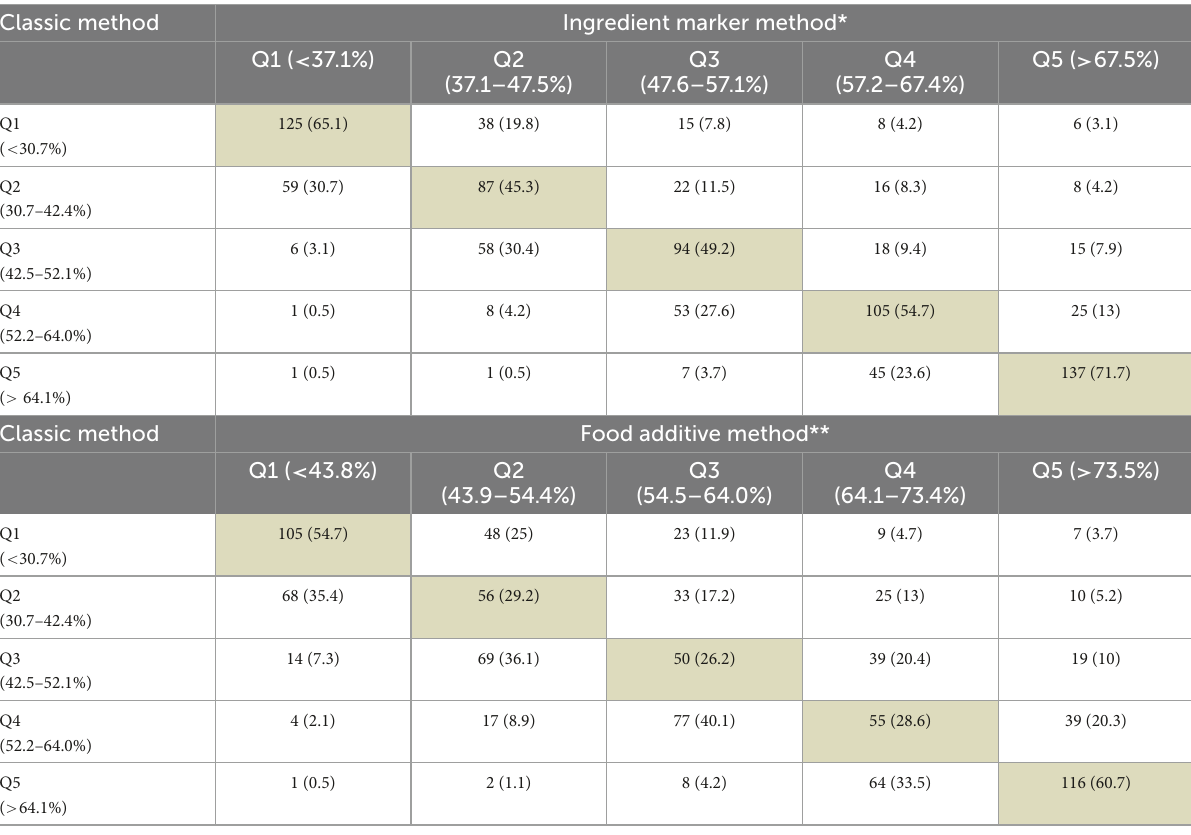
TABLE 5 Distribution ( n ; %) of quintiles of the caloric share of ultra-processed foods (% of total calories) in preschoolers’ diet according to different methods to identify